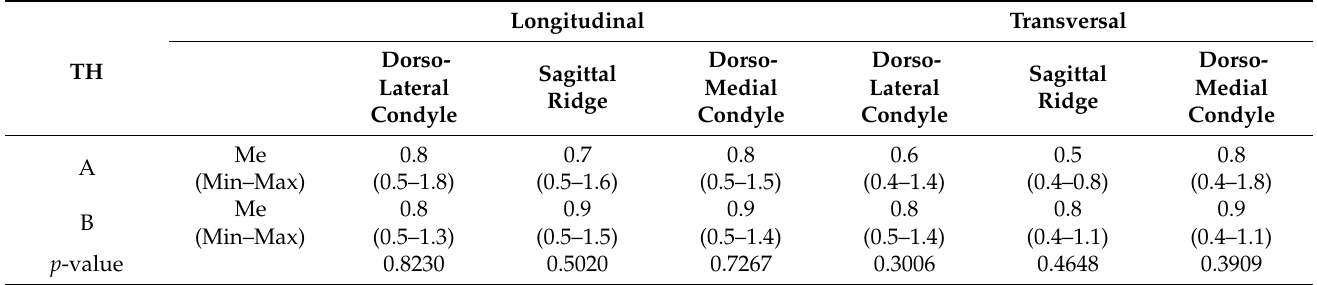
Table 3. Cartilage thickness results reported in millimetres, for thoroughbreds (TH), in Group A (A) and Group B (B).